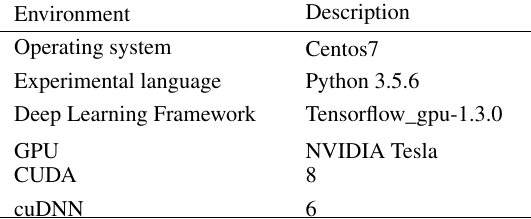
Table 2 Experimental environment